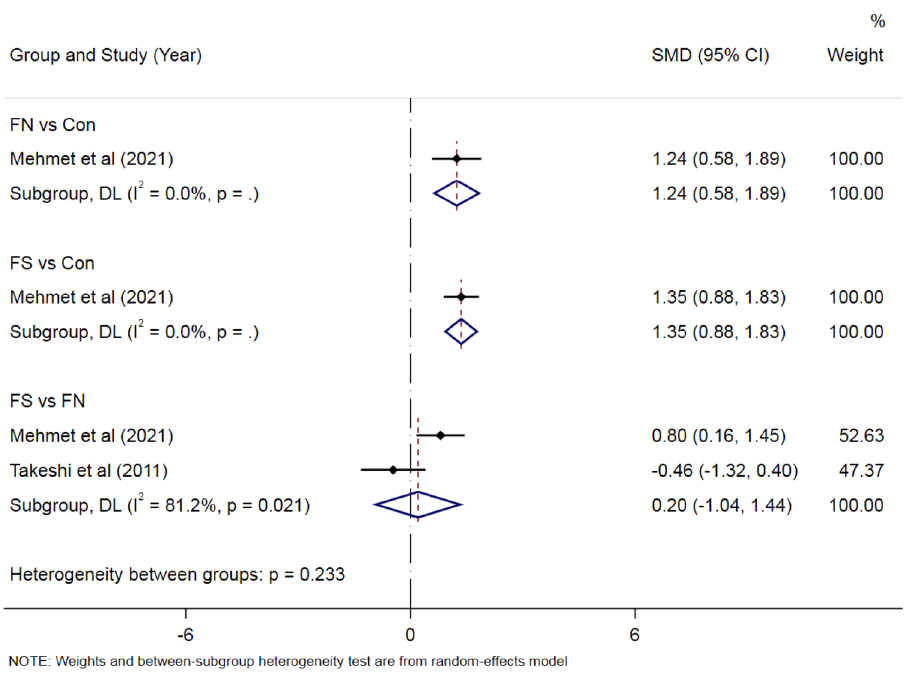
Figure 3. Forest plots of CSF HMGB1 levels in FS group, FN group and healthy